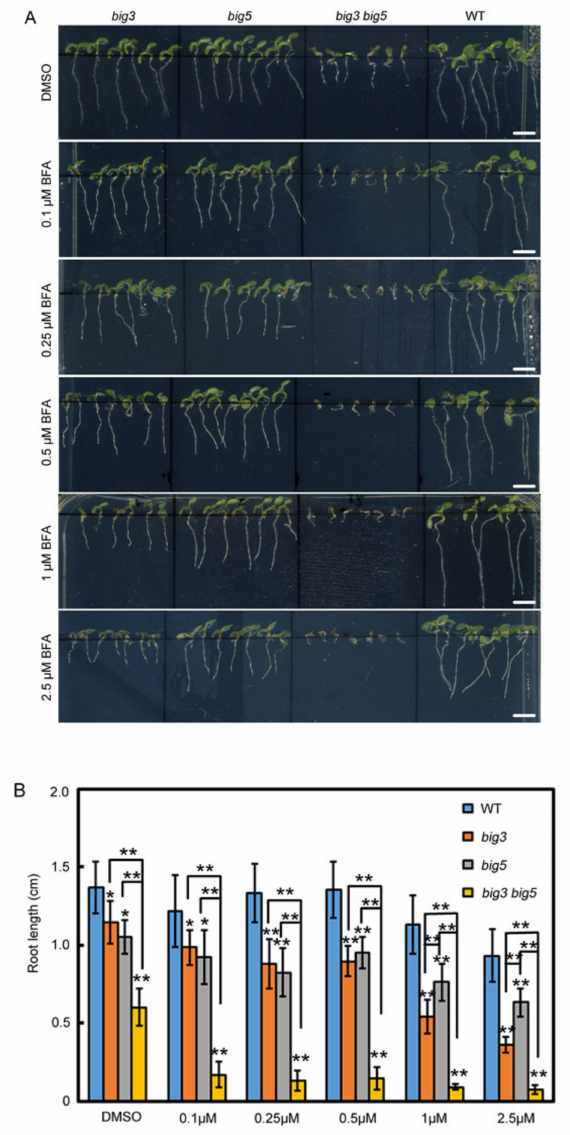
Figure 2. Root sensitivity of WT, big3 , big5 and big3 big5 seedlings to BFA. ( A ) two-day-old WT, big3 , big5 and big3 big5 seedlings germinated on 1/2 MS medium were transferred to the medium containing different concentrations of BFA (DMSO as a control). Bars = 0.5 cm. ( B ) quantification of the root length in ( A ). The values are presented as mean ± sd (n = 15), and analyzed with one-way ANOVA and multiple comparisons (*, p < 0.05; **, p <